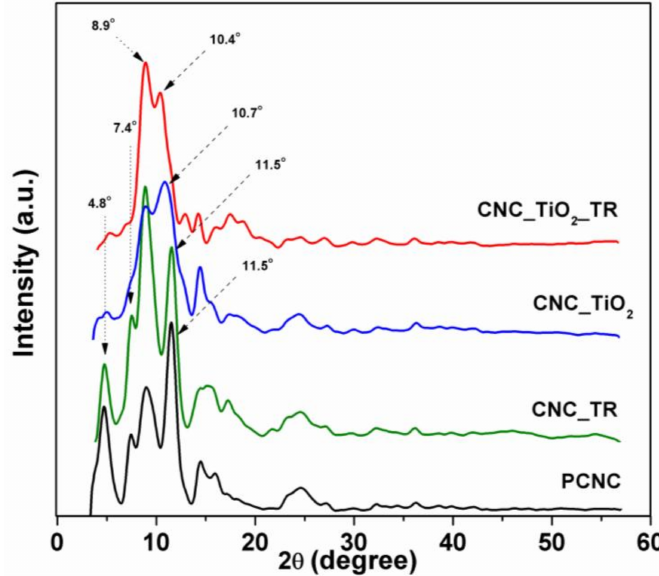
Figure 2. X-ray diffraction patterns of the obtained